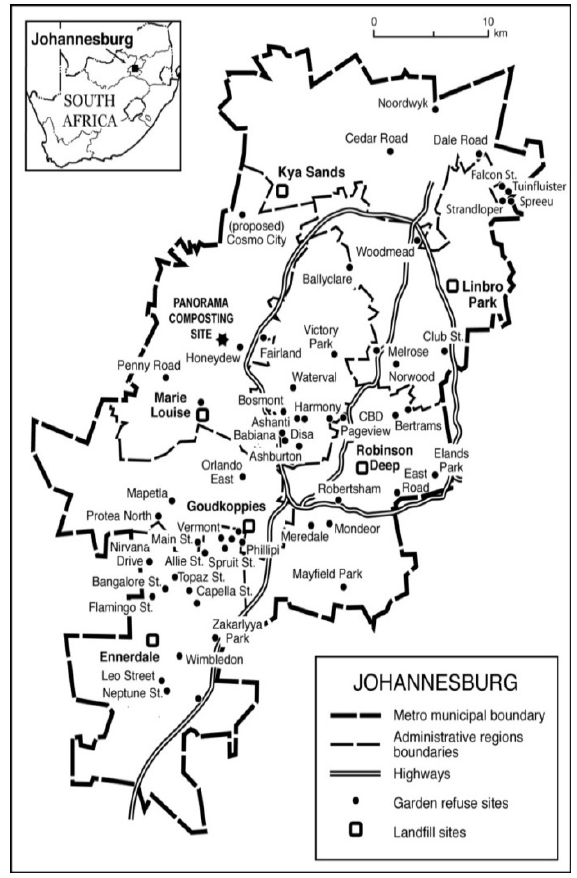
Fig. 1. Map of the City of Johannesburg showing the